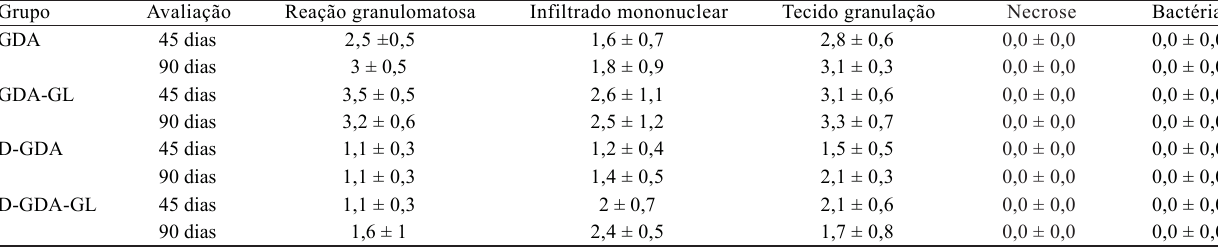
Tabela 1. Avaliação histomorfológica do infiltrado inflamatório nos